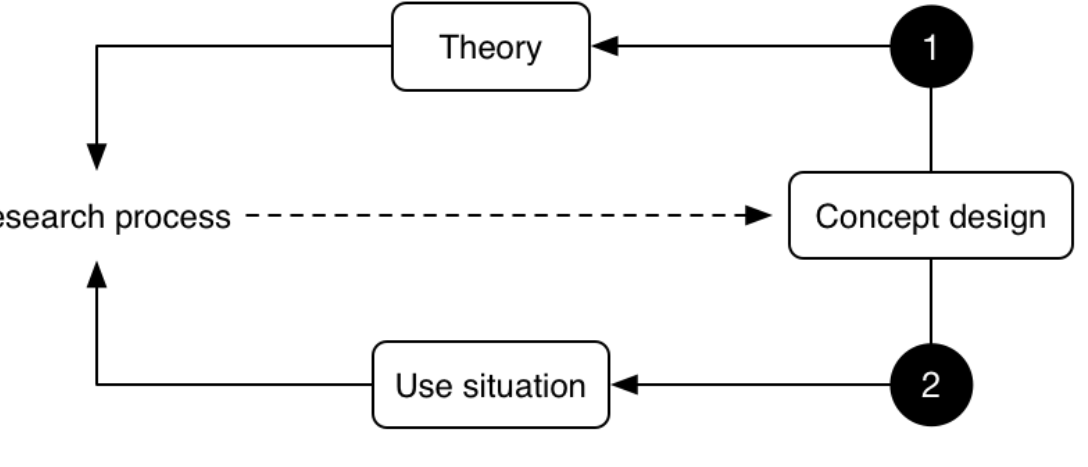
Figure 1: Shown here is the process of the concept-driven design research approach in relation to theory and use